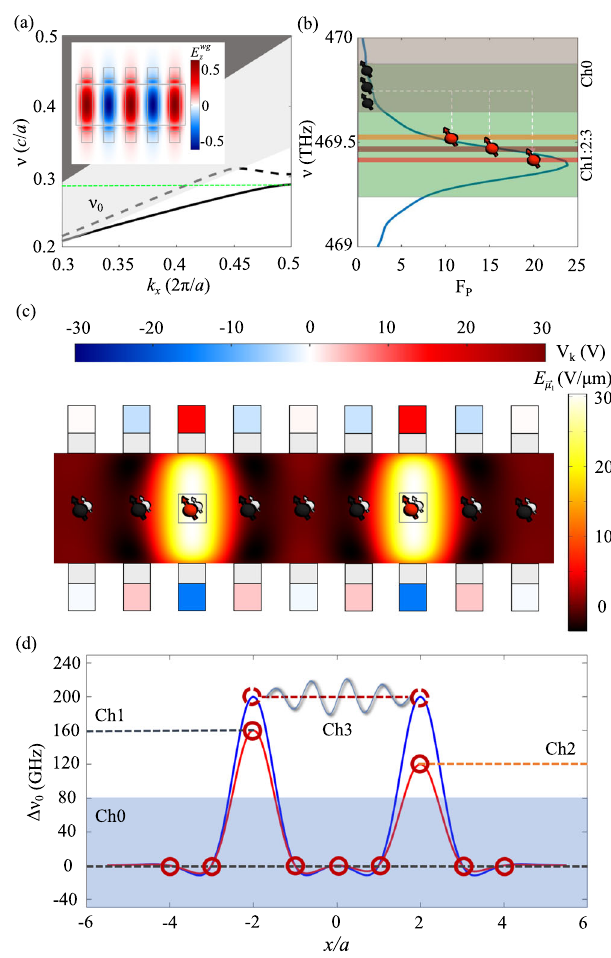
Fig. 3 | Coupling of quantum emitters to slow-light waveguide with spectral addressing. a Photonic TE band structure of the FPSA slow-light waveguide using the parametersshowninTable1.The dark (light)shaded regions indicate the light coneforpropagationinfreespace(substrate).Theinsetshowsthe z -componentof theelectric fi eldatthemidplaneofthediamond. b PurcellfactorfortheFPSAwith a fi nite number of periods N =100 near the bandgap. Green shading indicates the Starktuningrange,andthehorizontalshadingindicatesnon-interactingfrequency channels. c Electric fi eld pro fi le for placing two NVs at j =±2 on resonance. d NV Stark shift versus positions for two voltage con fi gurations. The blue curve shows theStarkshiftfortheelectric fi eldpro fi leshownin c .Theredcurveshowsanother voltage setting where two emitters are tuned to non-interacting